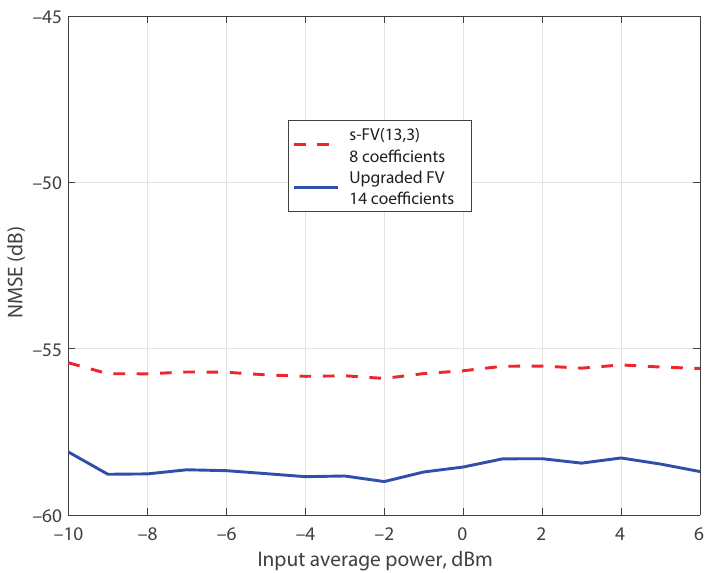
Figure 4. NMSE modeling performance over a 16 dB dynamic range. Coefficients estimated at an average output level of 19